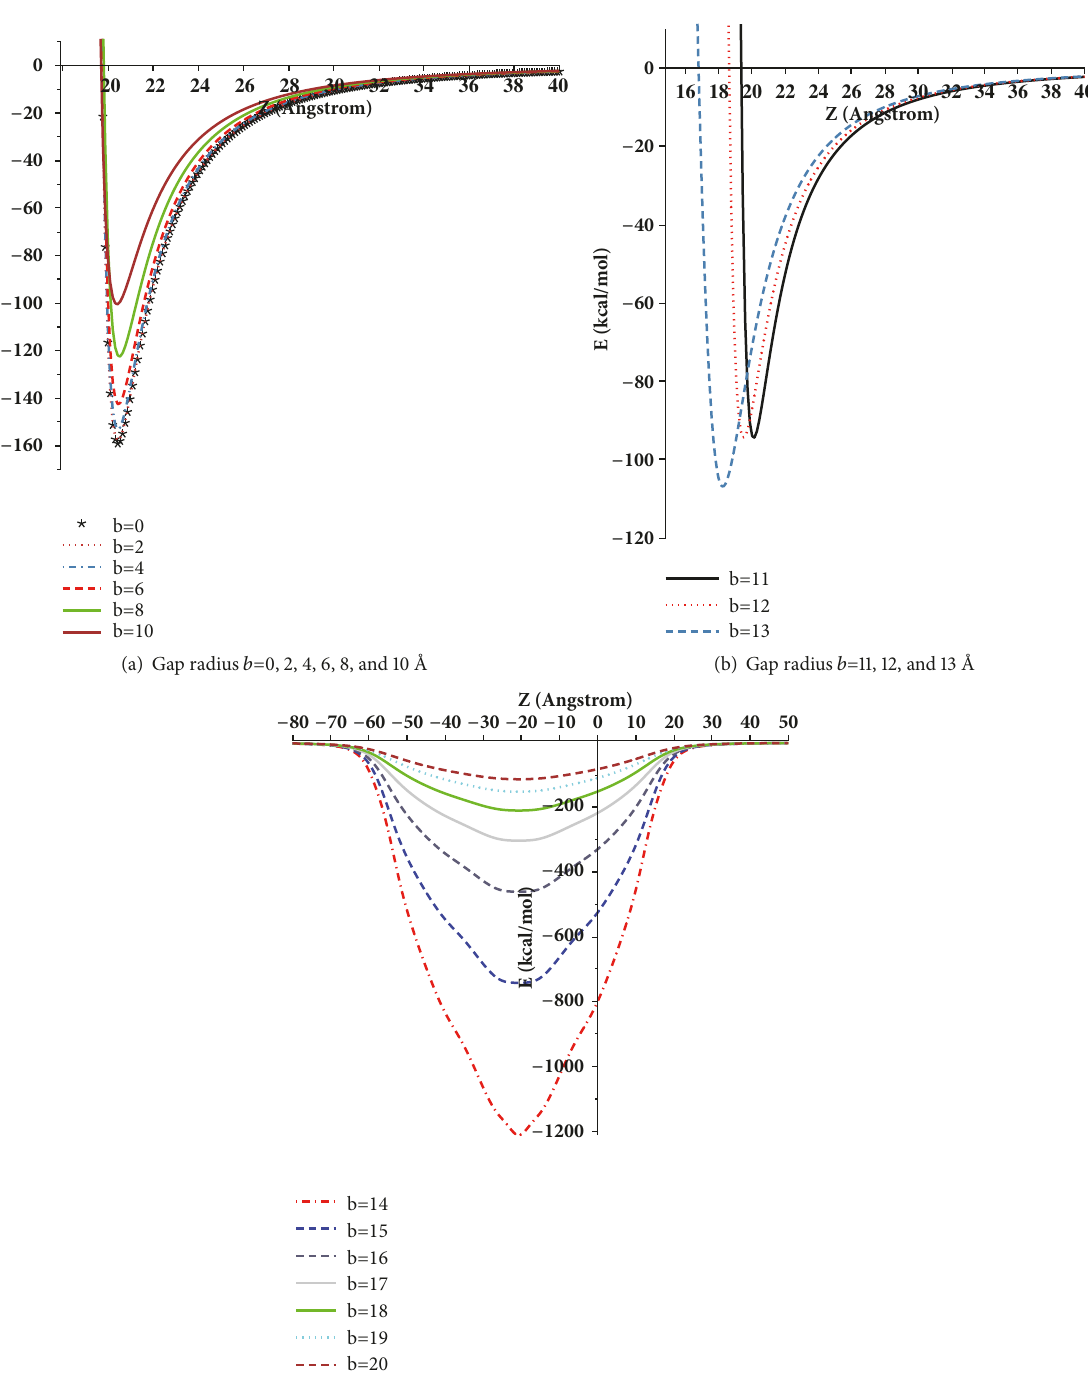
Figure 6: Total energy for dsDNA molecule interacting with different values of the gap radius 𝑏 with respect to the perpendicular distance 𝑍